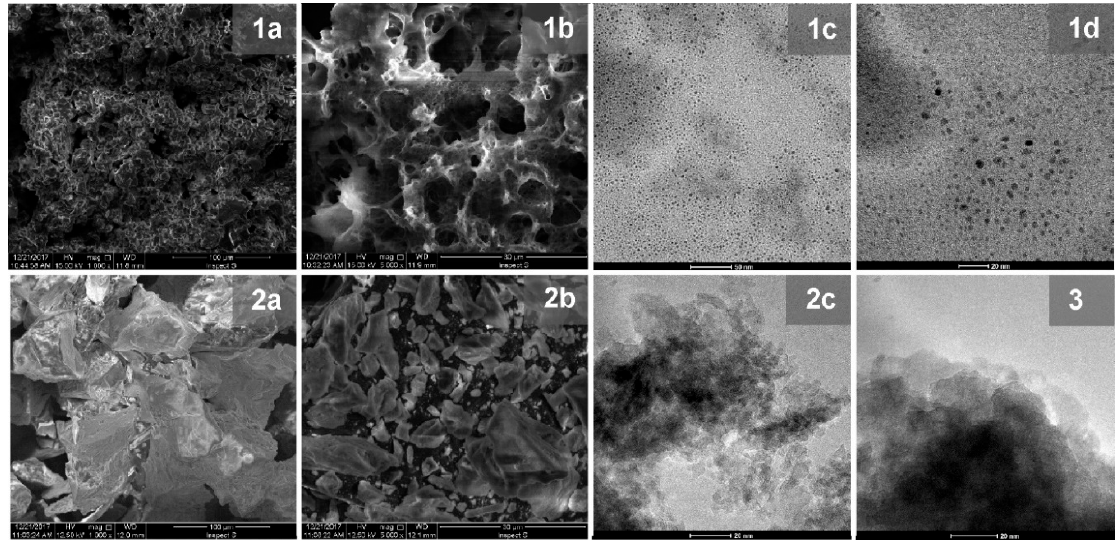
Figure 5. Images of graphene quantum dots (GQDs). ( 1a,b ) SEM, ( 1c,d ) transmission electron